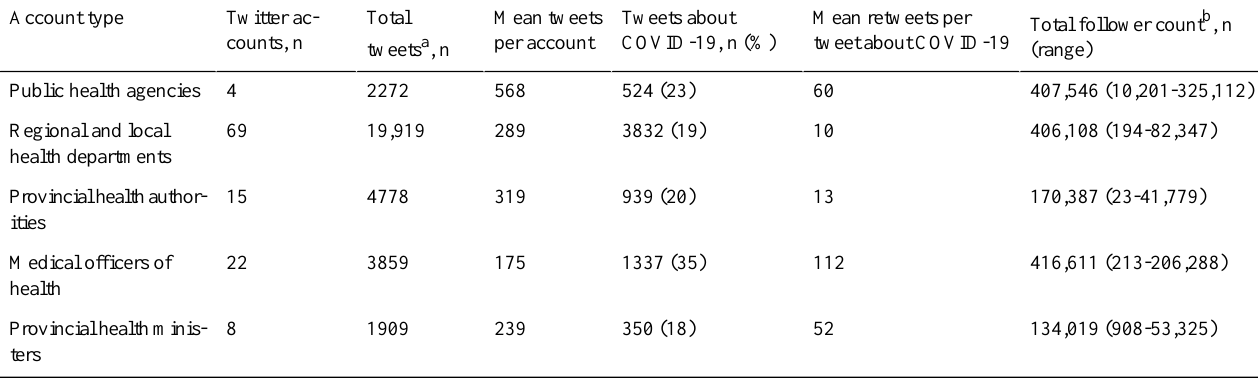
Table 1. Number of tweets and follower counts by account type, January 1, 2020, to June 30,